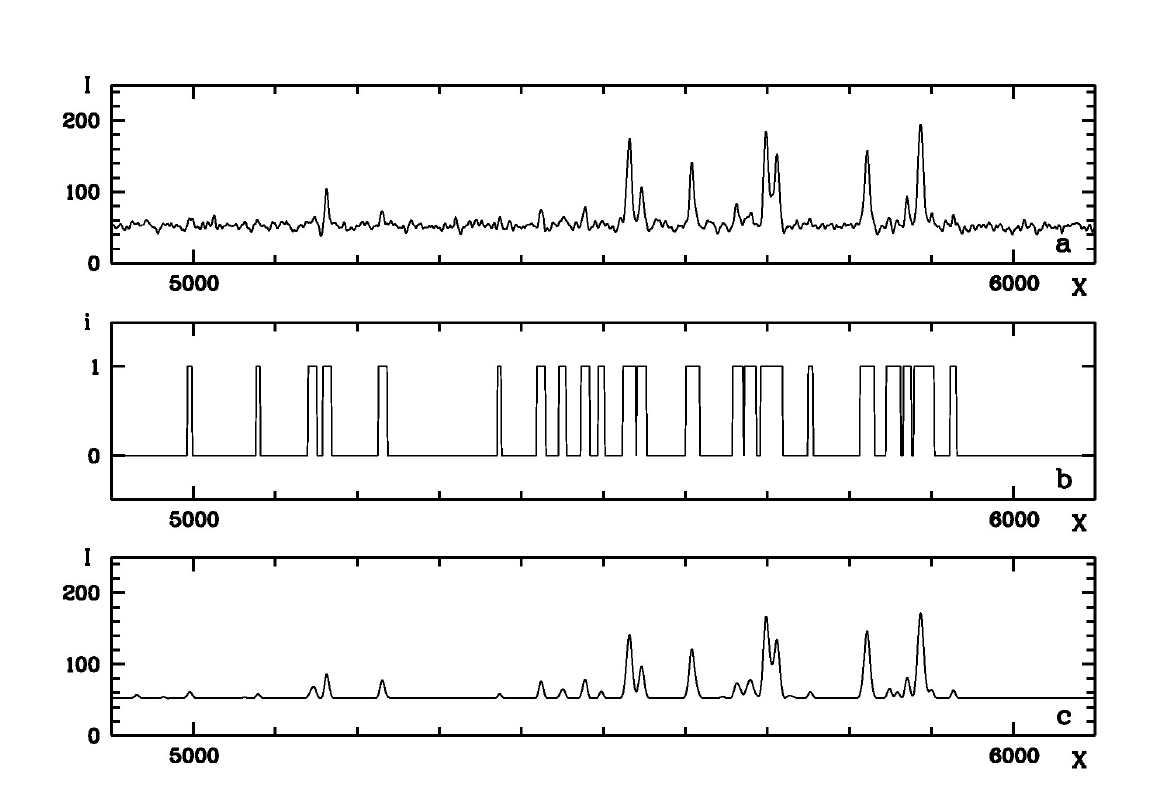
Figure 2. Photometrical slice for coordinate X for the central piece of the plate after making corrections for the flat field (a), diaphragm of the objects(b) and the final look (c